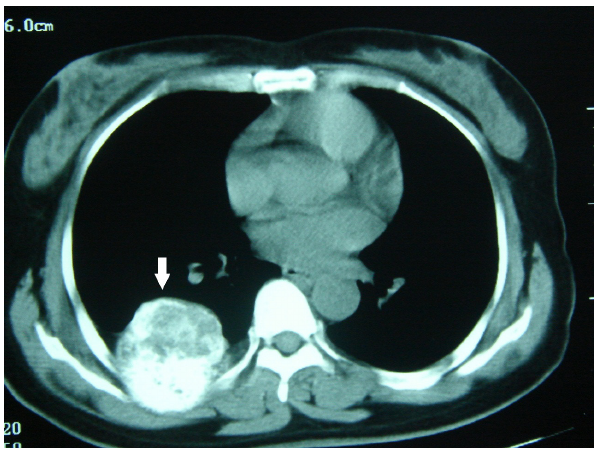
Figure 2: Chest computed tomography scan showed the localized expansive and heterogeneous growth of the tumor projecting toward the thoracic cavity